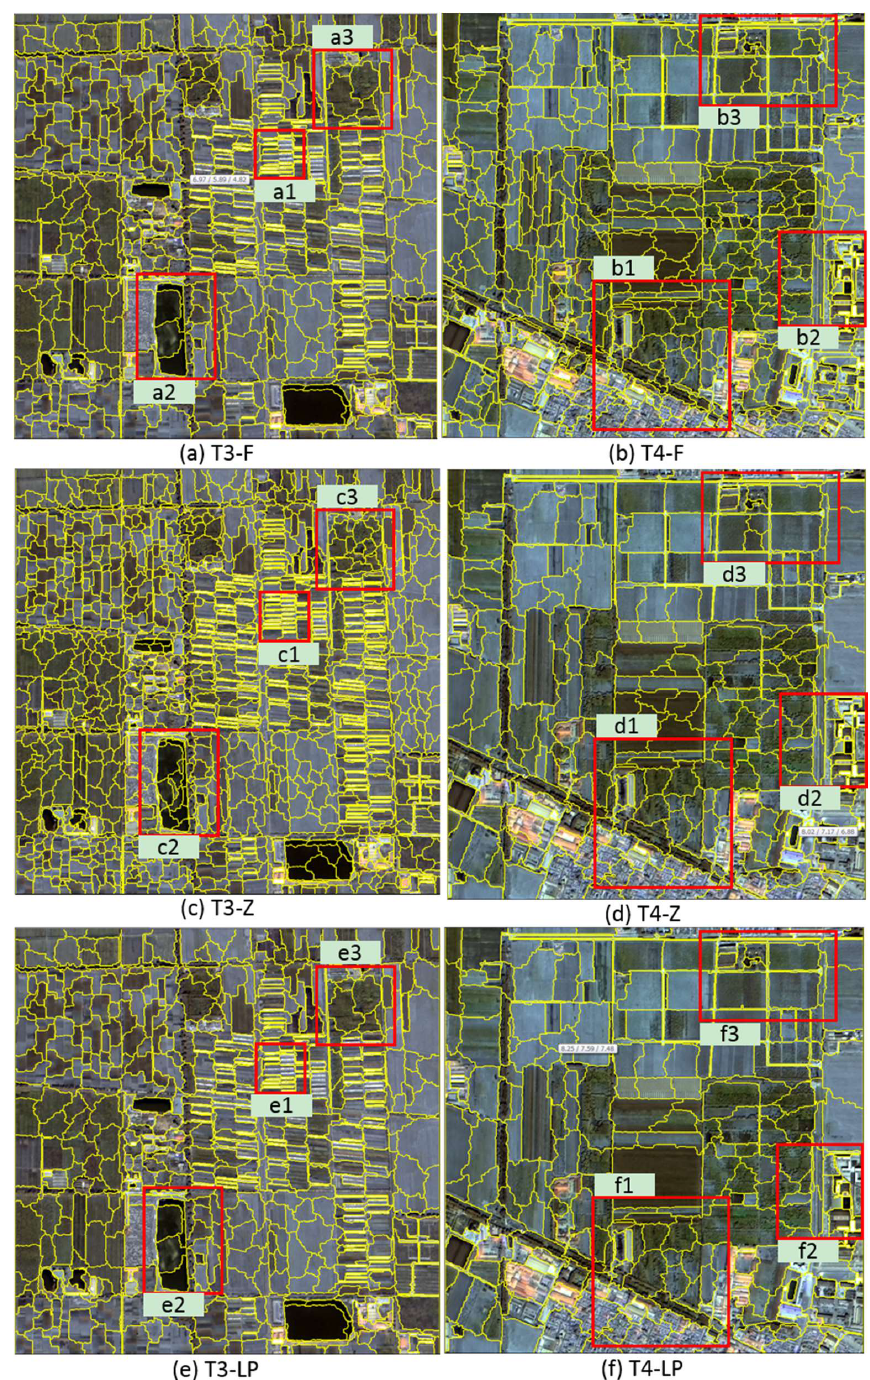
Figure 9. The segmentation results of the test images T3 and T4 produced by the MRS method with optimal scales obtained by the three combination methods.